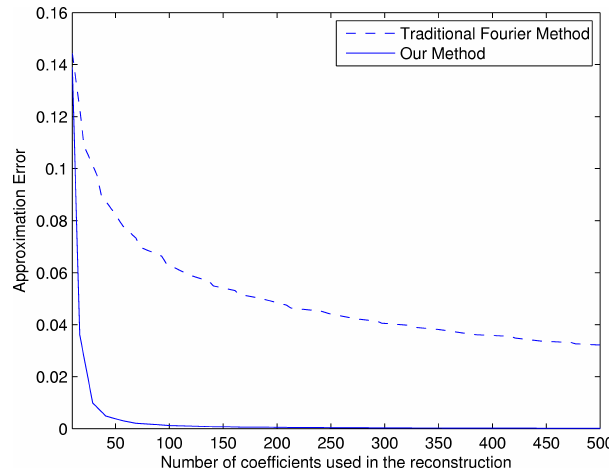
Fig. 2. Approximation of f ( x , y ) = e x + y by traditional Fourier method and our